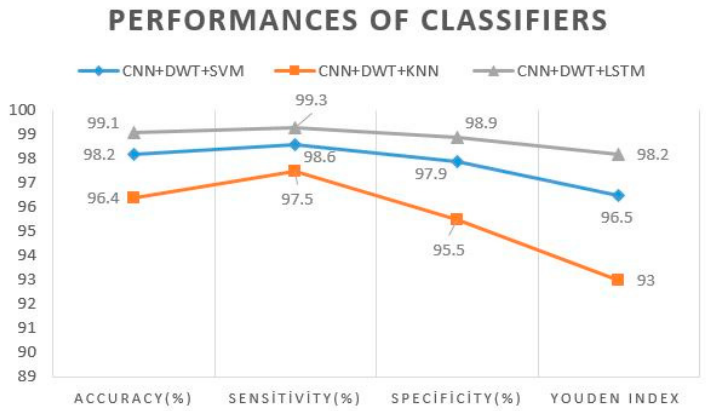
Figure 7. Performance of classifiers.